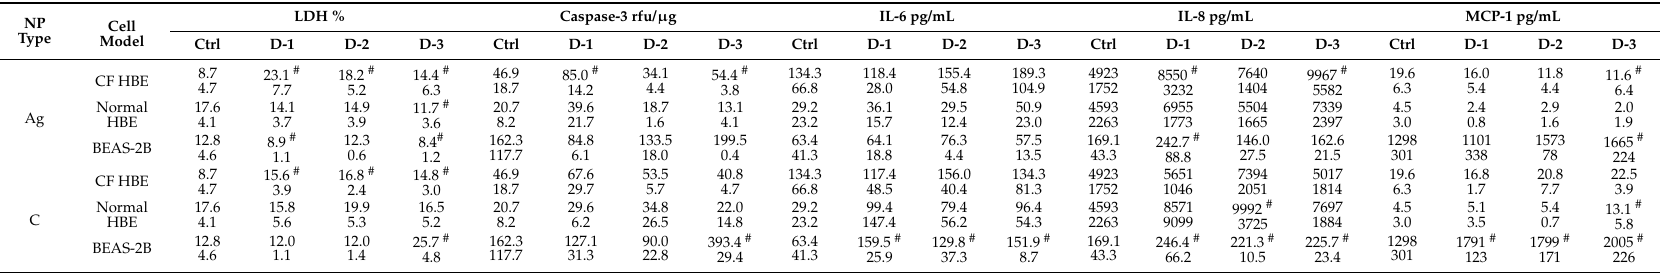
Table 4. Detailed data of changes in biomarkers in response to NP